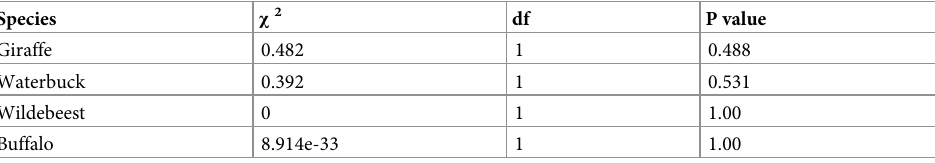
Table 3. Time that each species spent in a mixed-species group in the wild compared to the zoo, assessed using Chi-squared tests of independence. Species χ 2 df P value Giraffe 0.482 1 0.488 Waterbuck 0.392 1 0.531 Wildebeest 0 1 1.00 Buffalo